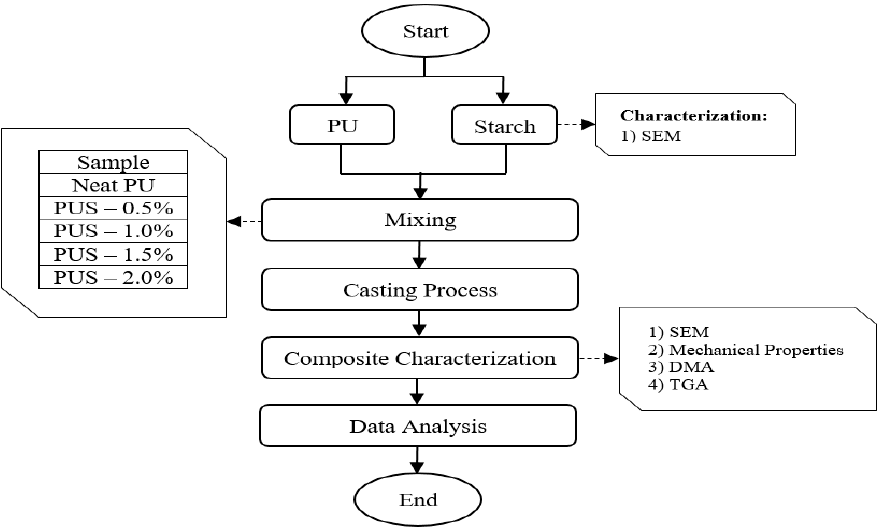
Figure 12. Sample preparation and experimental set-up.